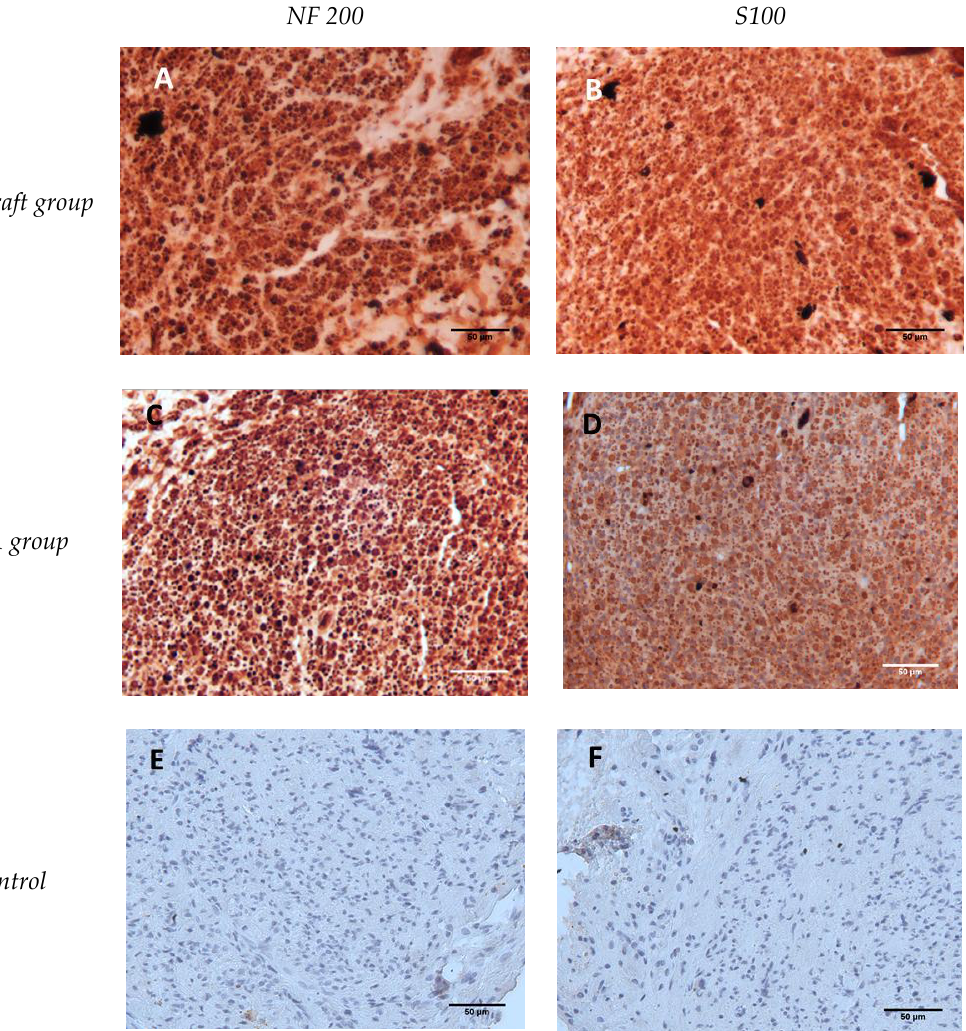
Figure 5. Immunohistochemical results 12 weeks after implantation. ( A , C ) transverse sections of, autograft group and hUA group respectively, stained with NF200 antibody; ( B , D ) transverse sections of autograft group and hUA group respectively, stained with S100; ( E , F ) transverse sections without primary antibody served as a negative control. Original magnification 40× scale bar 50μm.